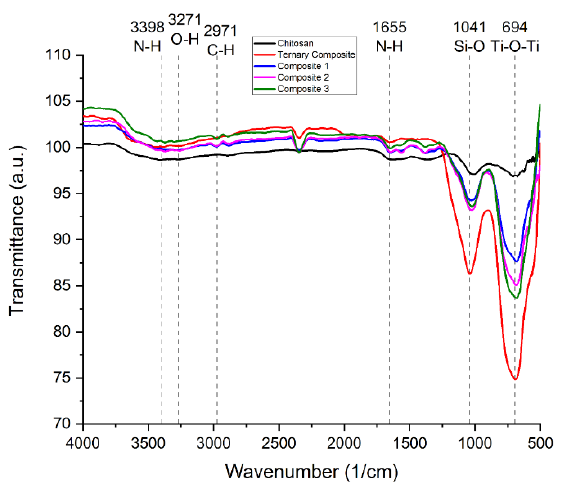
Figure 3. FT-IR spectra of ternary composite, chitosan, and their three composites.